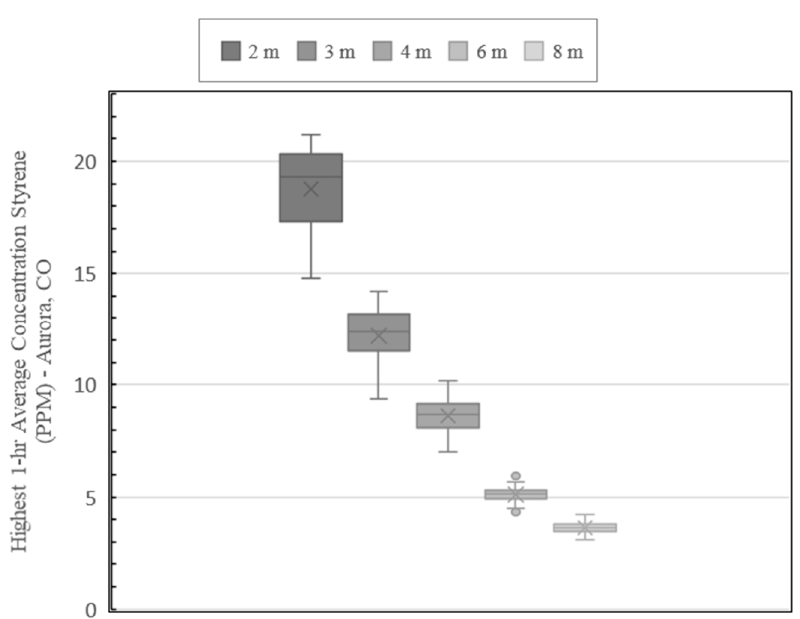
Figure 10. 5-year Modelled Styrene Concentration by Radial Distance (Aurora Site).